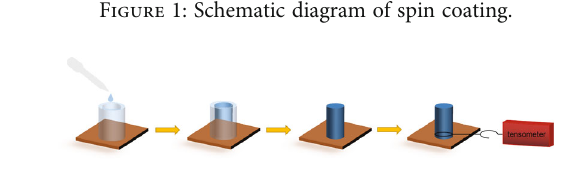
Figure 2: Schematic diagram of ice adhesion strength test